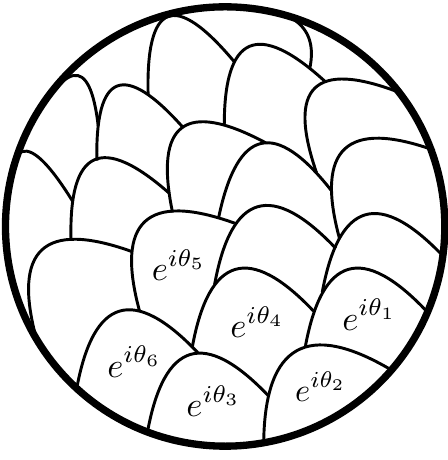
Figure 2 . The Moyal map associates a unitary matrix to a collection of N phases, several of which are shown, each within non-overlapping regions of unit